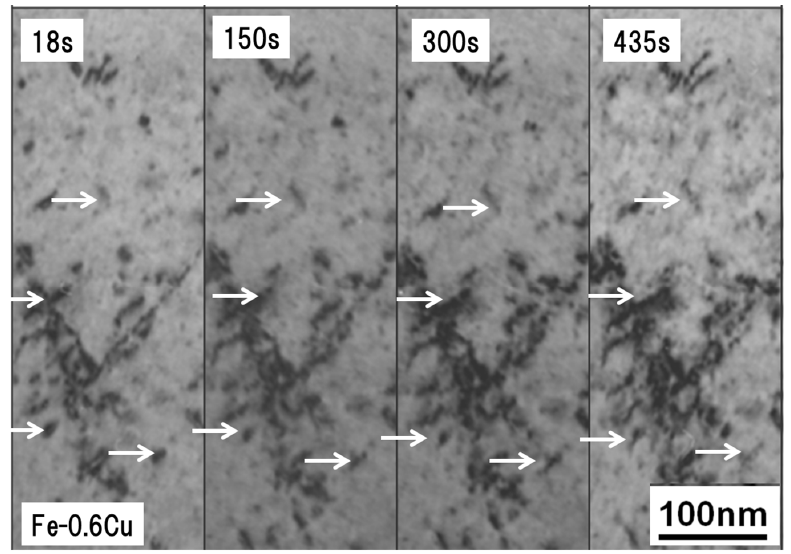
Figure 4. Microstructural evolution of the neuron-irradiated Fe-0.6wt%Cu alloy during electron irradiation at 1.0 MeV at room temperature. Irradiation time (s) is inserted in the figure. The nature of the dislocation loop (shown by arrows) was identified as interstitial type.